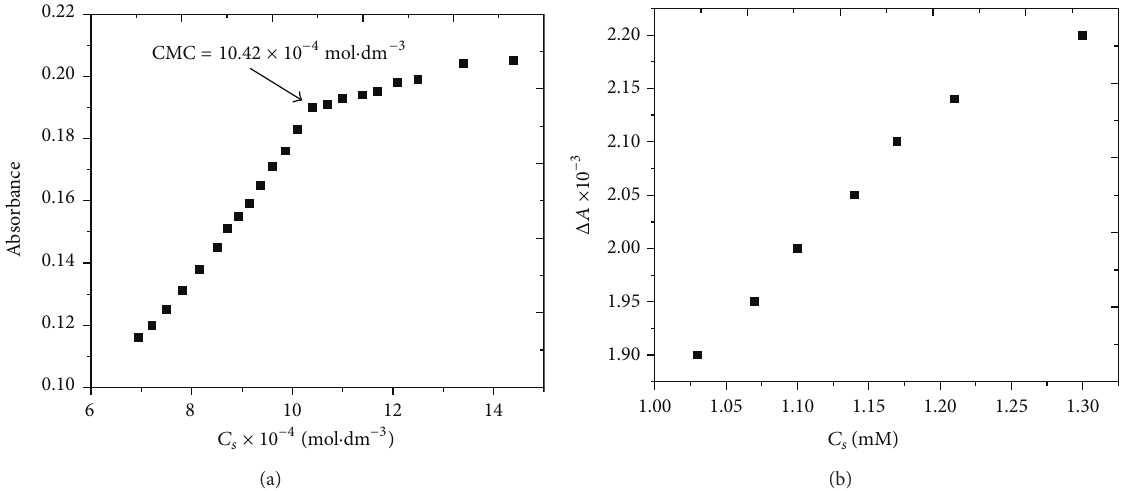
Figure 3: (a) Plot of simple absorbance of reactive orange 122 as a function of CTAB concentration. (b) Plot of differential absorbance of reactive orange 122 as a function of CTAB